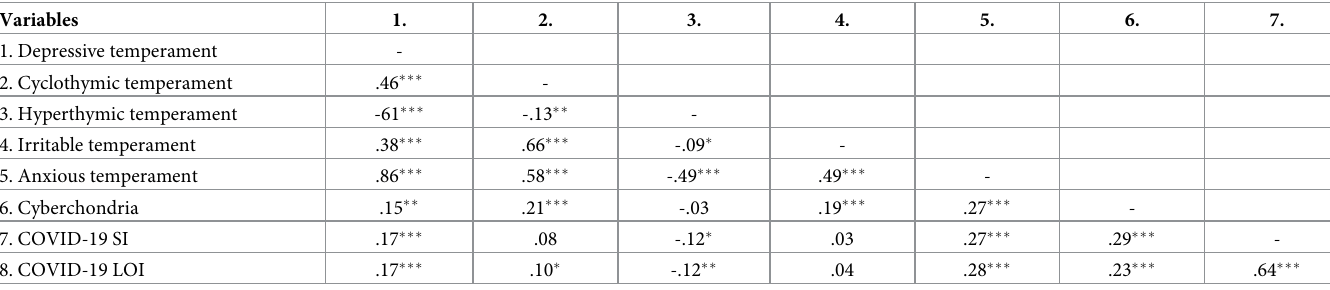
Table 3. Pearson r correlation coefficients between analysed variables in the whole sample (N = 499).